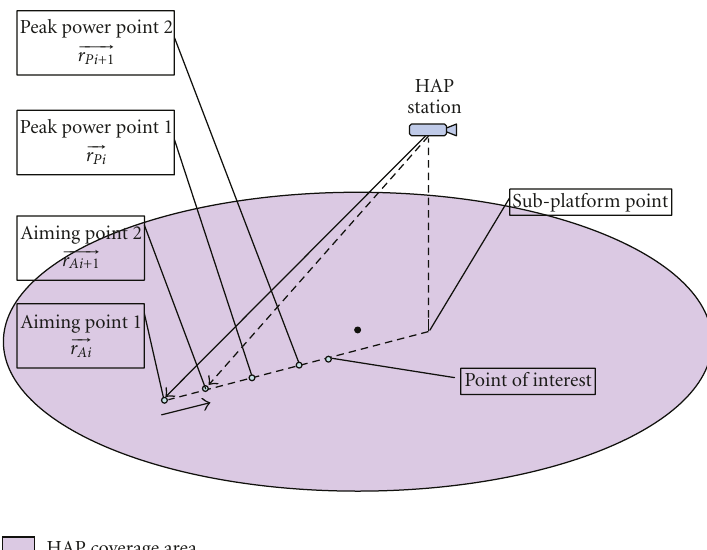
Figure 5: The small step scheme description.